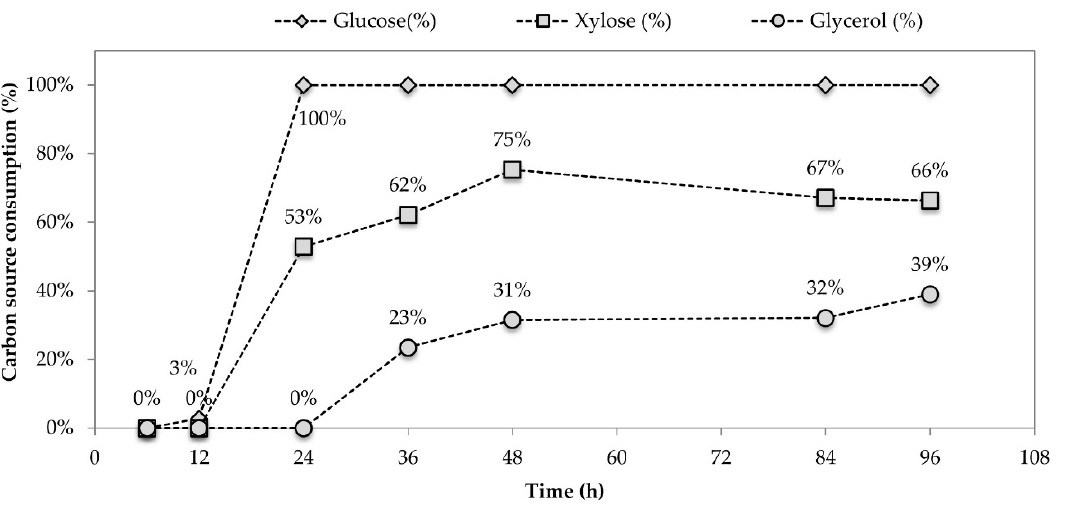
Figure 5. Kinetics of SBHH and WG consumption by C. necator DSMz 545 in MSM medium, per- formed in 250 mL flask.